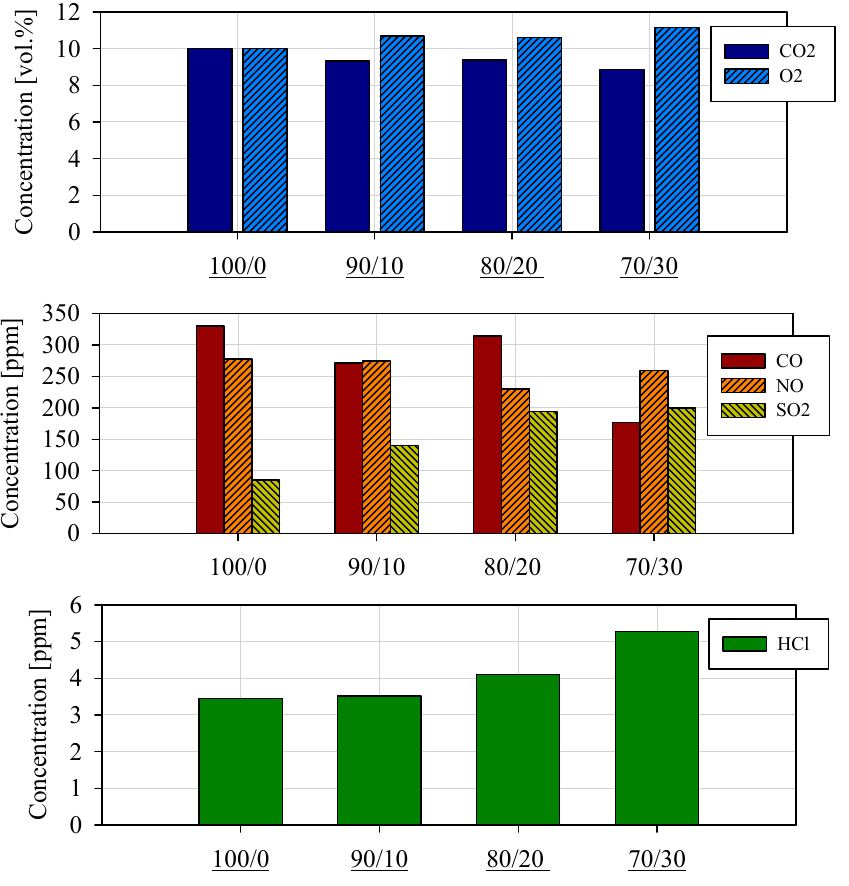
Figure 5. Fuel gas concentration from the co-combustion.